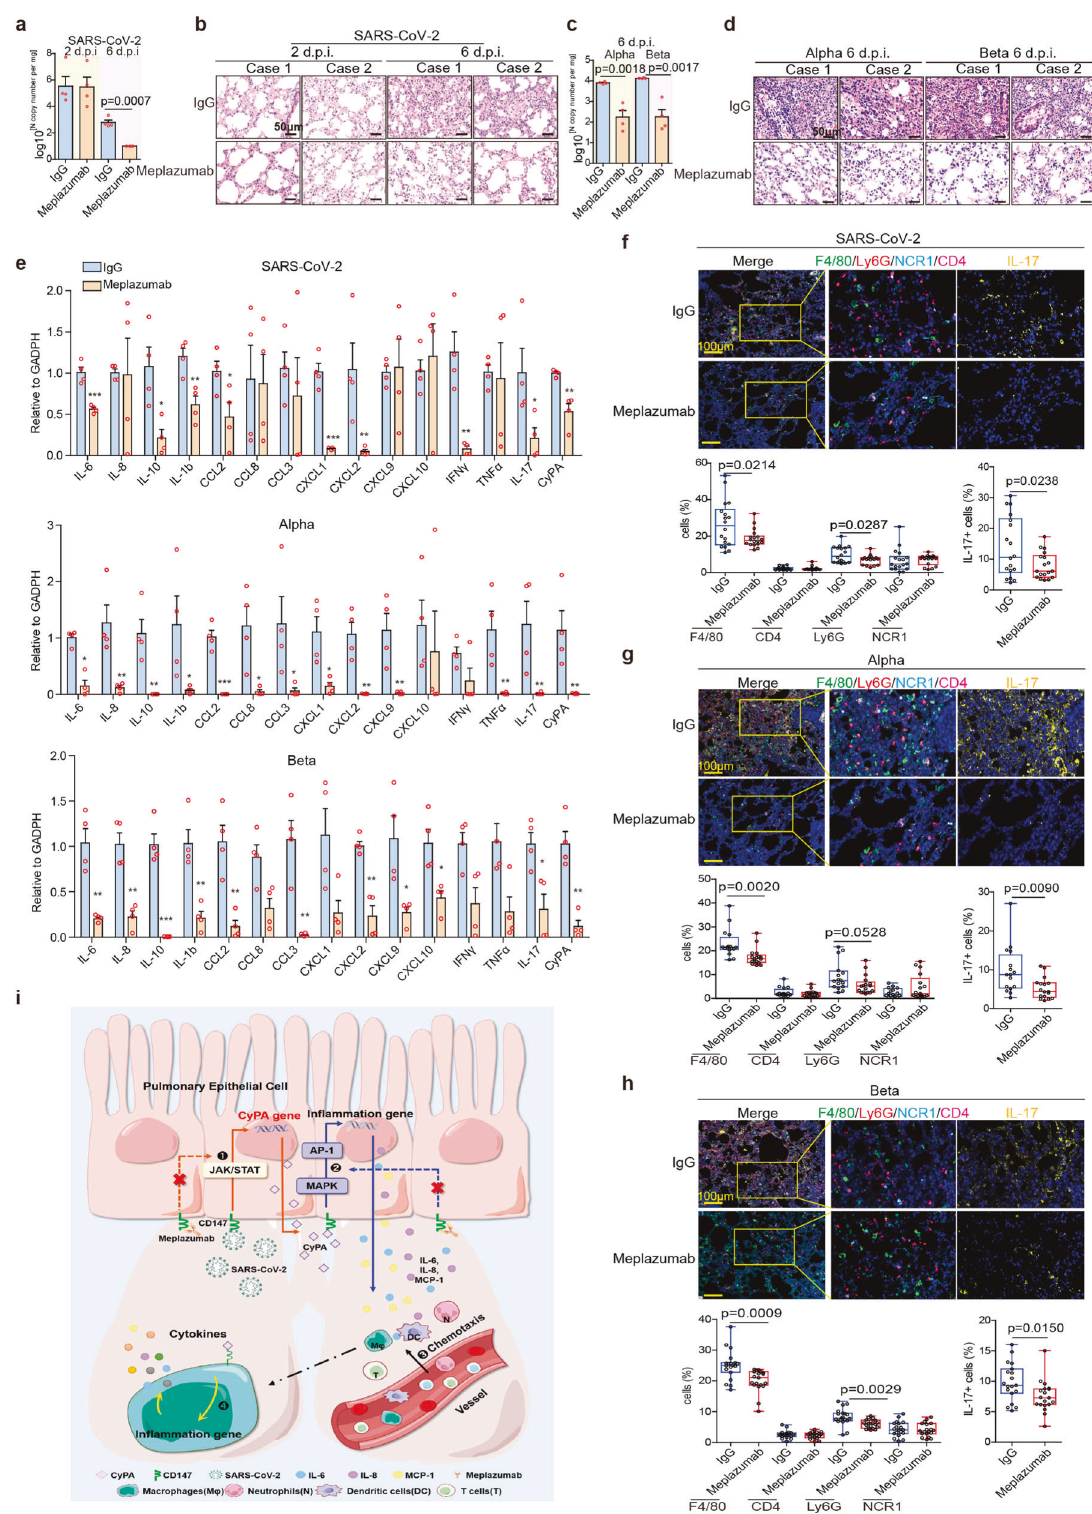
cells including Th17 cells, neutrophils, NK cells, 48,49 where ACE2 is rarely expressed. 50 Thus, SARS-CoV-2-infected hCD147 transgenic mice well recapitulate the symptoms of COVID-19 pneumonia, providing a good model for studying the pathogenic mechanism and pharmacodynamics of agents against